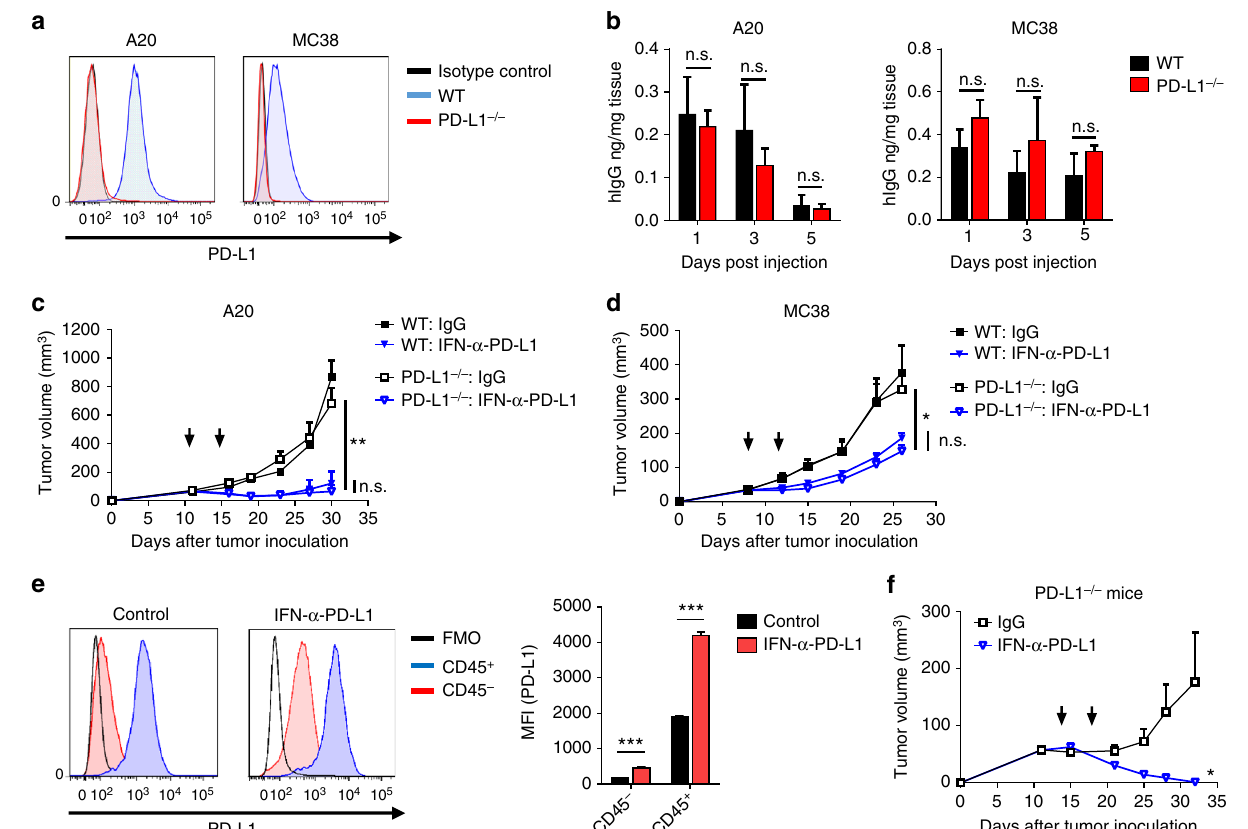
Fig. 4 PD-L1 expressed in either host or tumor cells is suf fi cient for the antitumor effects of IFN α -armed anti-PD-L1. a PD-L1 levels in B220 + cells of WT and PD-L1 -/- A20 tumors, and CD45 - cells of WT and PD-L1 -/- MC38 tumors were measured by fl ow cytometry. b WT or PD-L1 -/- tumor-bearing mice were injected i.v. with 30 µ g of IFN α -anti-PD-L1. Tumor tissues were collected at various time points post injection. Concentrations of fusion protein were measured by ELISA. c Mice ( n = 4 – 5) bearing WT or PD-L1 -/- A20 tumors were treated with control Ig or IFN α -anti-PD-L1 on days 11 and 15. Tumor growth was measured twice per week. d Mice ( n = 5 – 6) bearing WT or PD-L1 -/- MC38 tumors were treated with control Ig or IFN α -anti-PD-L1 on days 8 and 12. e MC38 tumor-bearing mice were treated with IFN α -anti-PD-L1. Two days later, tumor tissues were collected. PD-L1 levels in CD45 - vs. CD45 + cells were evaluated by fl ow cytometry. A representative graph is shown on the left, and MFI is shown on the right. f PD-L1 -/- mice ( n = 4 – 5) were inoculated with MC38 cells. Mice were treated with 25 µ g of control Ig or IFN α -anti-PD-L1 on days 14 and 18. Tumor growth was measured twice per week. Data indicate mean ± SEM and are representative of at least two independent experiments. * p < 0.05; ** p < 0.01; *** p < 0.001; n.s. not signi fi